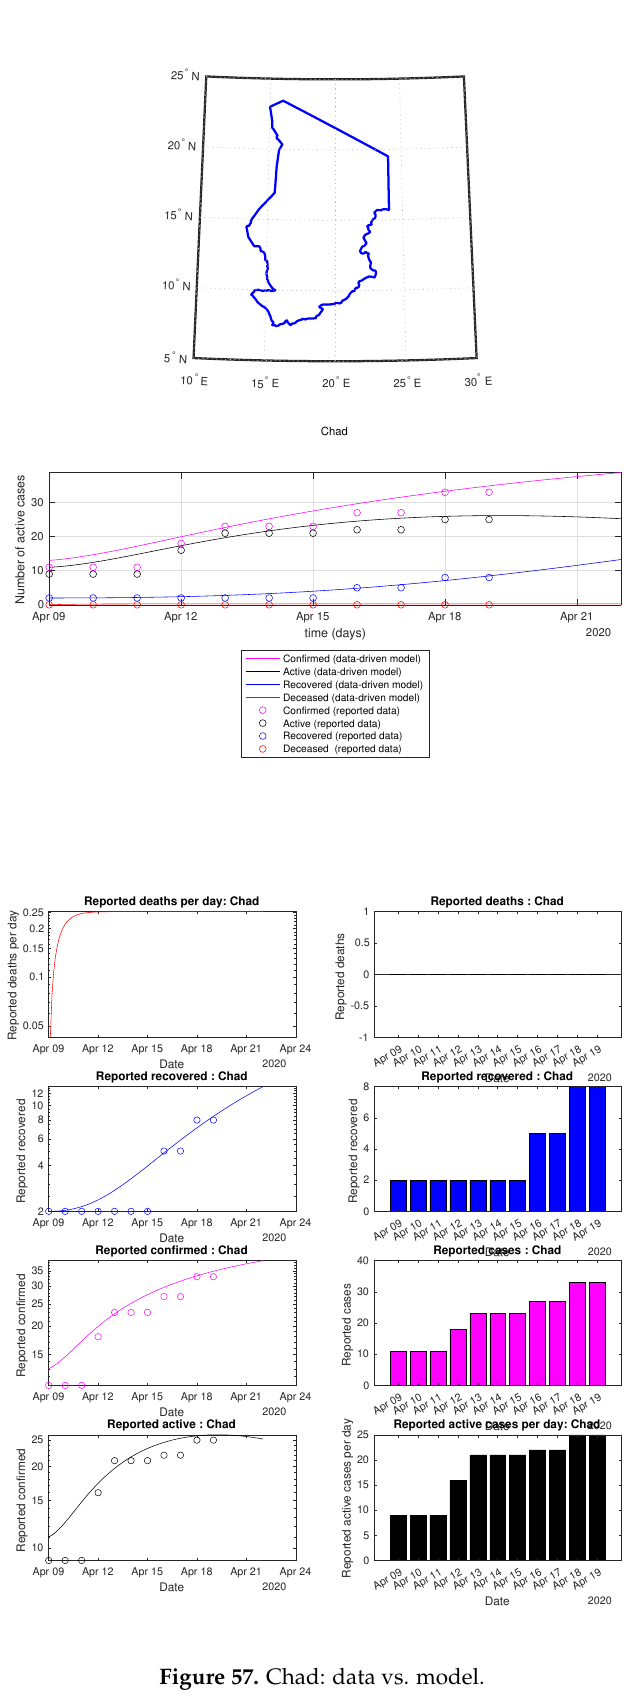
Figure 57. Chad: data vs.